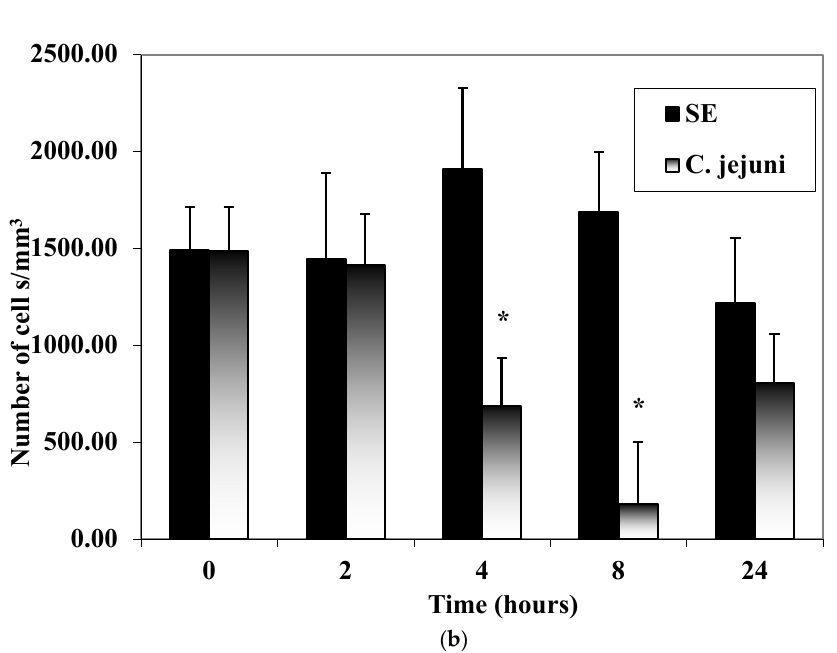
Figure 1. ( a , b ) Peripheral blood counts. Five chicks from each of the treatment groups described above were randomly selected at 0, 2, 4, 8, and 24 h post-injection. Blood smears were prepared. Leukocyte cell counts of lymphocytes and large mononuclear cells (LMNs, monocytes, blast cells, heterophils) were made microscopically using oil immersion. The numbers of heterophils per mm − 3 were calculated for each chick from the total and differential leukocyte counts. Significant differences are indicated with an asterisk * ( p ≤